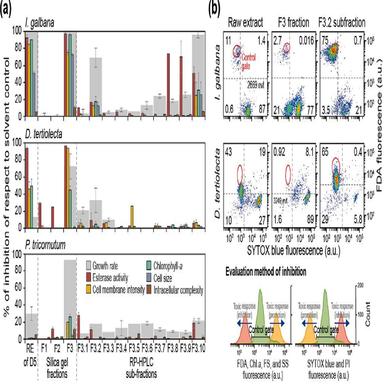
(a) Results of microalgal bioassays (Isochrysis galbana, Dunaliella tertiolecta, and Phaeodactylum tricornutum) to exposures of raw organic extract (RE), silica gel fractions, and RP-HPLC fractions of D5 sediment. (b) Dot plot of double staining I. galbana and D. tertiolecta to exposures of RE, F3, and F3.2.